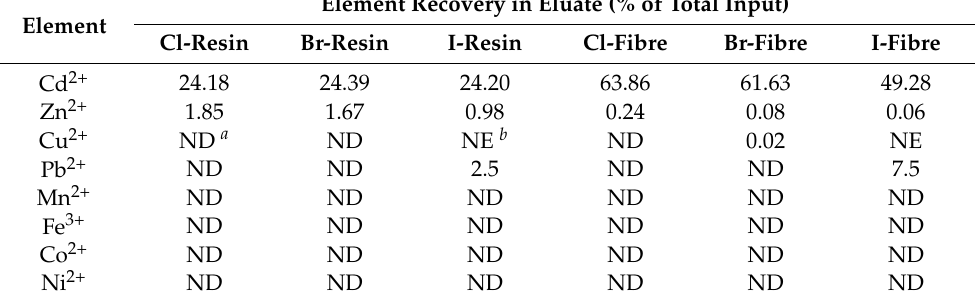
Table 4. Metal recovery by water elution.